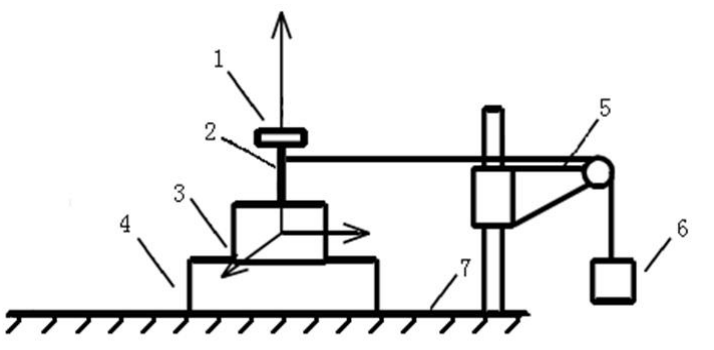
Figure 4. Diagram of static calibration experiment setup: (1) loading plate, (2) calibration shaft, (3) three-axis force sensor, (4) indexing plate, (5) pulley block, (6) weights, (7)